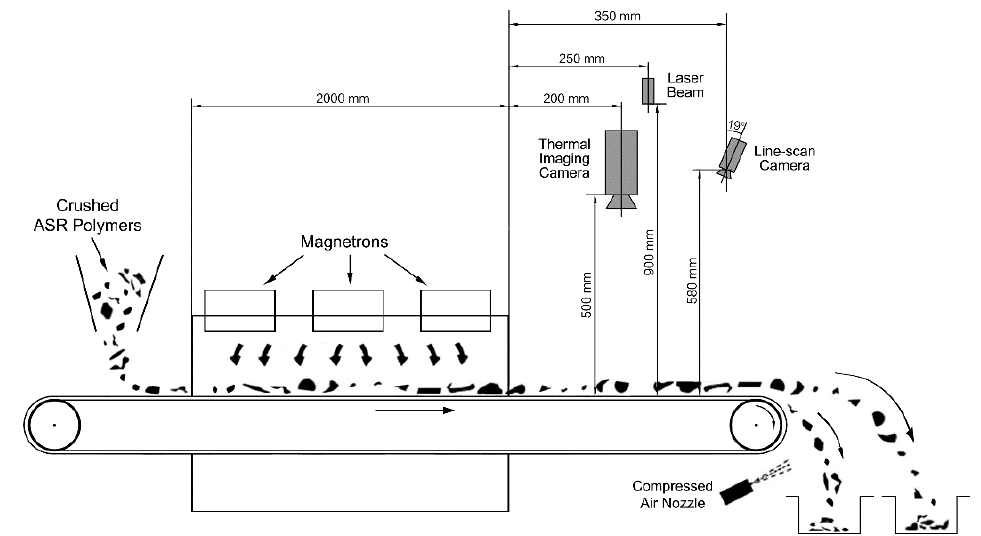
Figure 6. Installation of the sensor system on the conveyor microwave facility.